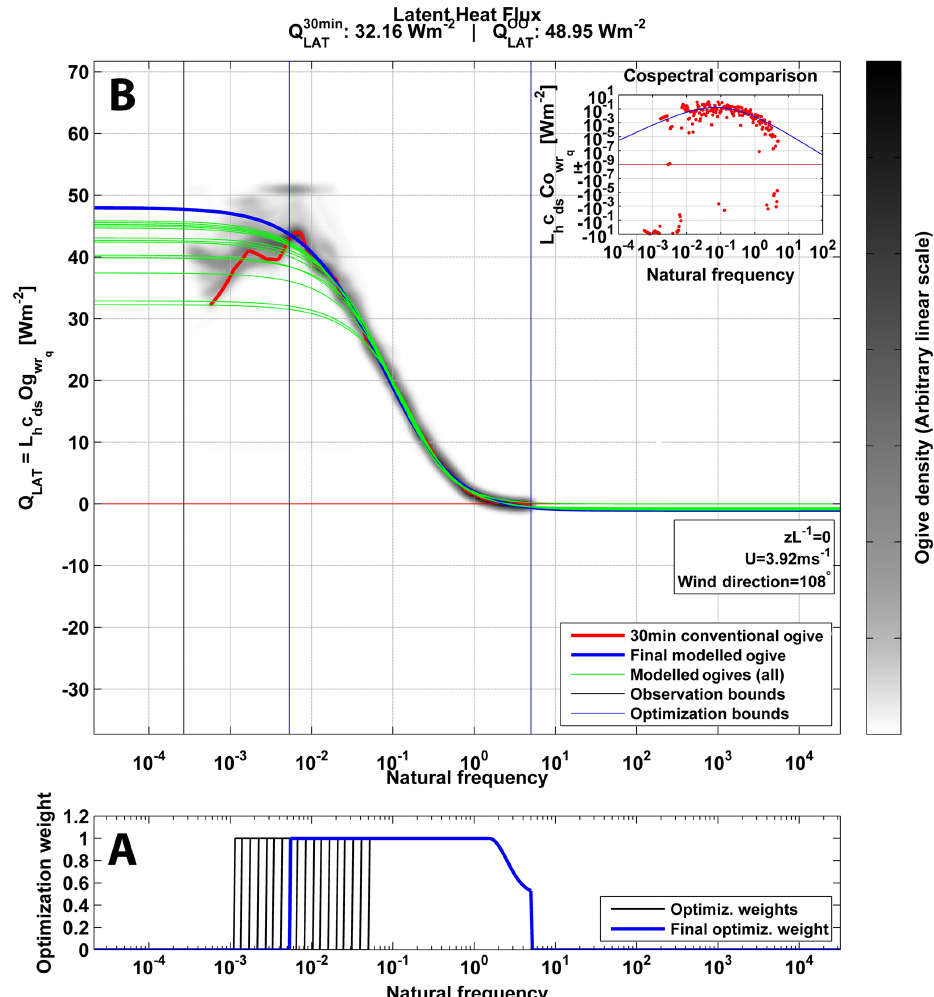
Figure 13. 60min observation of latent heat flux recorded at Abisko on 12 July 2012 at 8:50p.m. LT. (a) The 18 frequency interval op- timization weights (black lines) and the final optimization weight (blue line) are shown alongside (b) the corresponding optimized ogive solutions (green lines), the final ogive solution (blue line) and the optimization bounds of the final ogive solution (vertical blue lines). Otherwise, the illustration is similar to Fig.